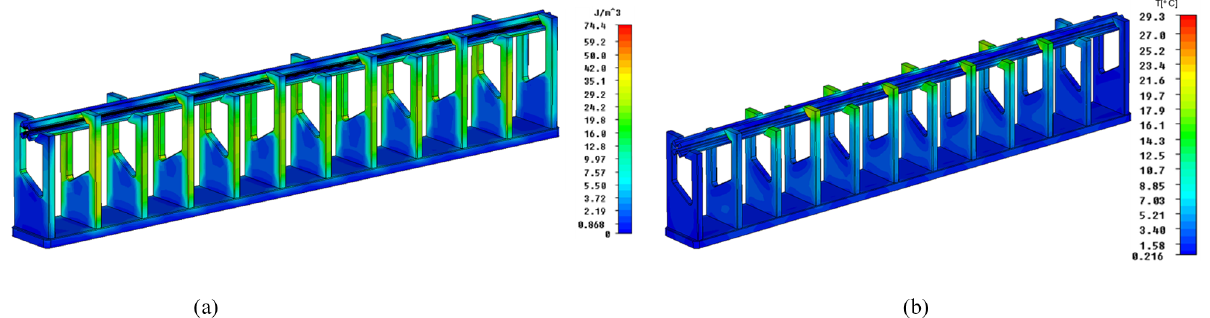
FIG. 12. Temperature distributions on the rf structure without and with the cooling